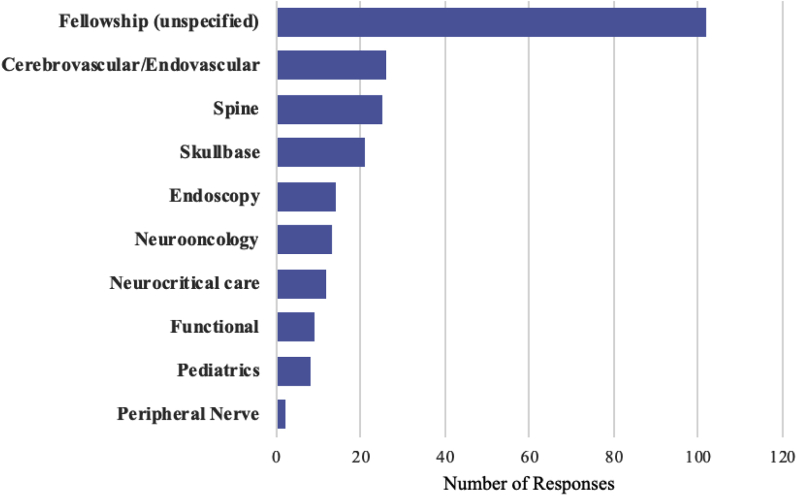
Requested fellowships from young neurosurgery respondents. A total of 232 individuals expressed interest in additional fellowship training. Of the specified fields (102 unspecified), most respondents requested training in cerebrovascular (n = 26), spine (n = 25) and skull base (n = 21).